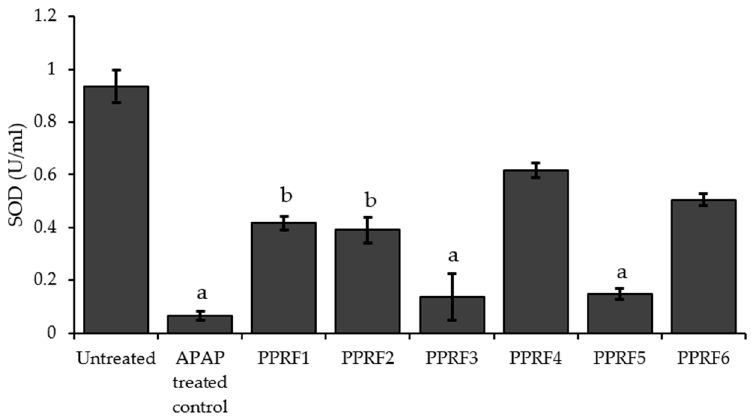
Figure 4. Effect of PPRF treatment on the SOD levels of APAP-treated HepG2 cells. The values are expressed as mean ± SD. Significant differences ( p < 0.05) from three replicates of independent experiments. Bars with the same letters are not significantly different ( p < 0.05). APAP: Acetaminophen.